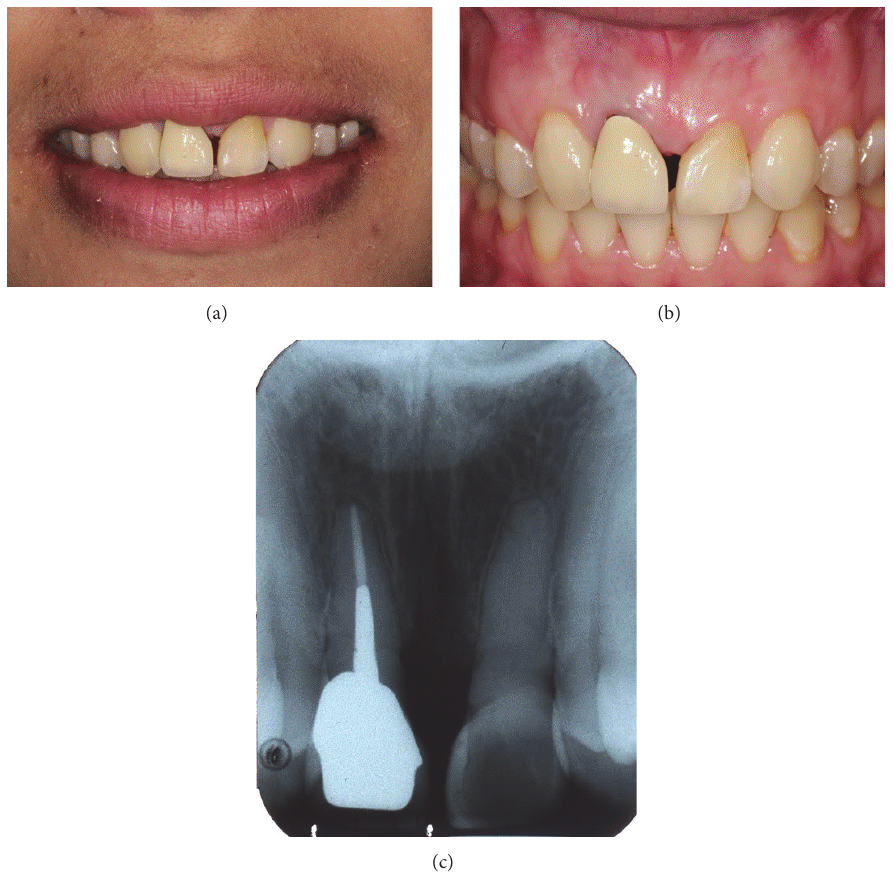
Figure 1: Pretreatment extra and intraoral photograph and periapical radiograph. (a) Smile photograph. (b) Intraoral photograph (front view) showing a midline diastema. (c) Periapical radiograph of the lateral